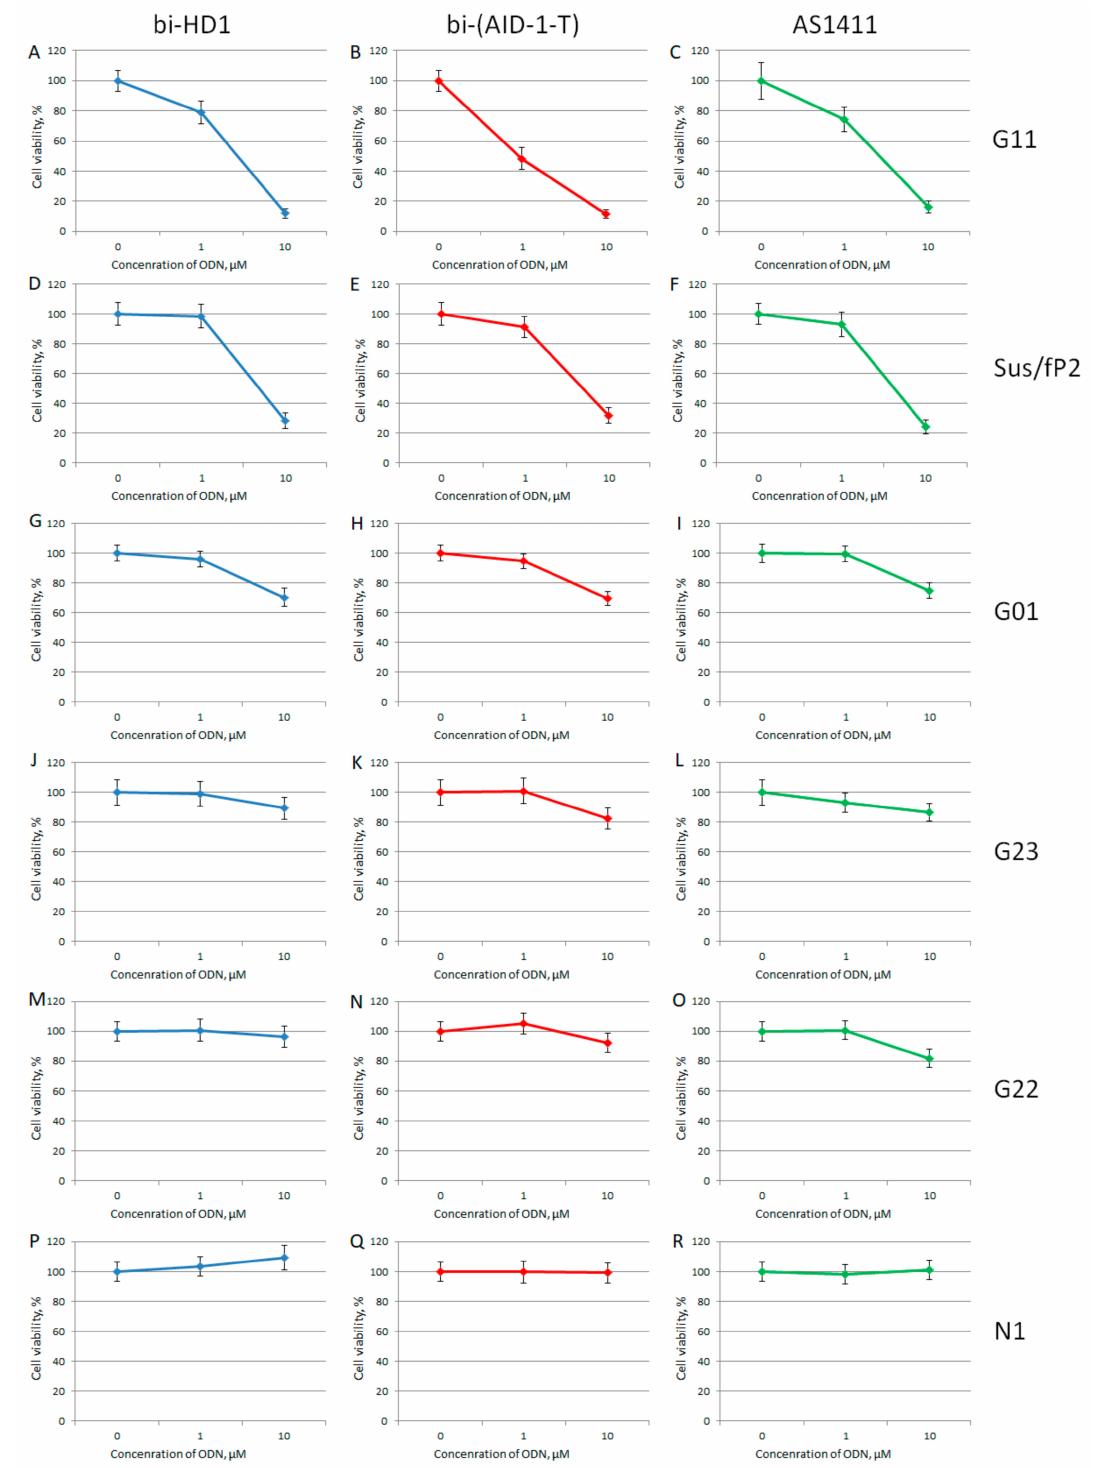
Figure 8. MTT assay data on the cell viability of six patient primary glioma cell cultures after bi-GQ treatment with three different concentrations (0.1; 1.0, and 10 µ M) for 72 h. Patient primary glioma cell cultures: G11 ( A – C ), Sus/fP2 ( D – F ), G01 ( G – I ), G23 ( J – L ), G22 ( M – O ), N1 ( P – R ). bi-HD1 (blue), bi-(AID-1-T) (red), AS1411 (green). Data are shown as (mean +/ − S.D.). Patient data are in the Table